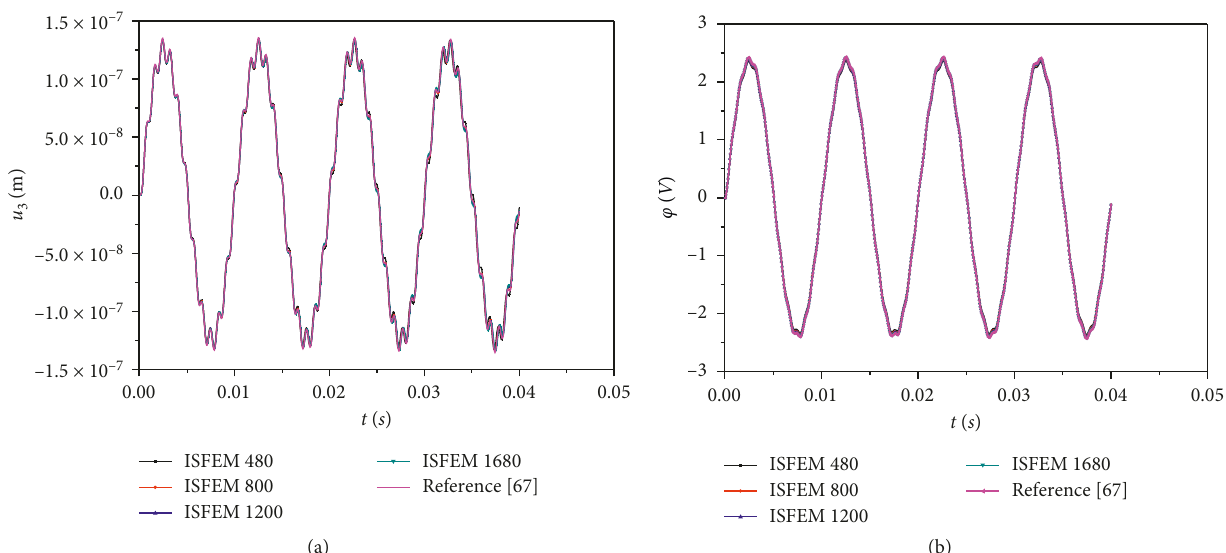
Figure 5: Variations of the displacement u 3 and electrical potential φ at the loading point with time when the gradient parameter was n (a) Displacement. (b) Electrical potential.